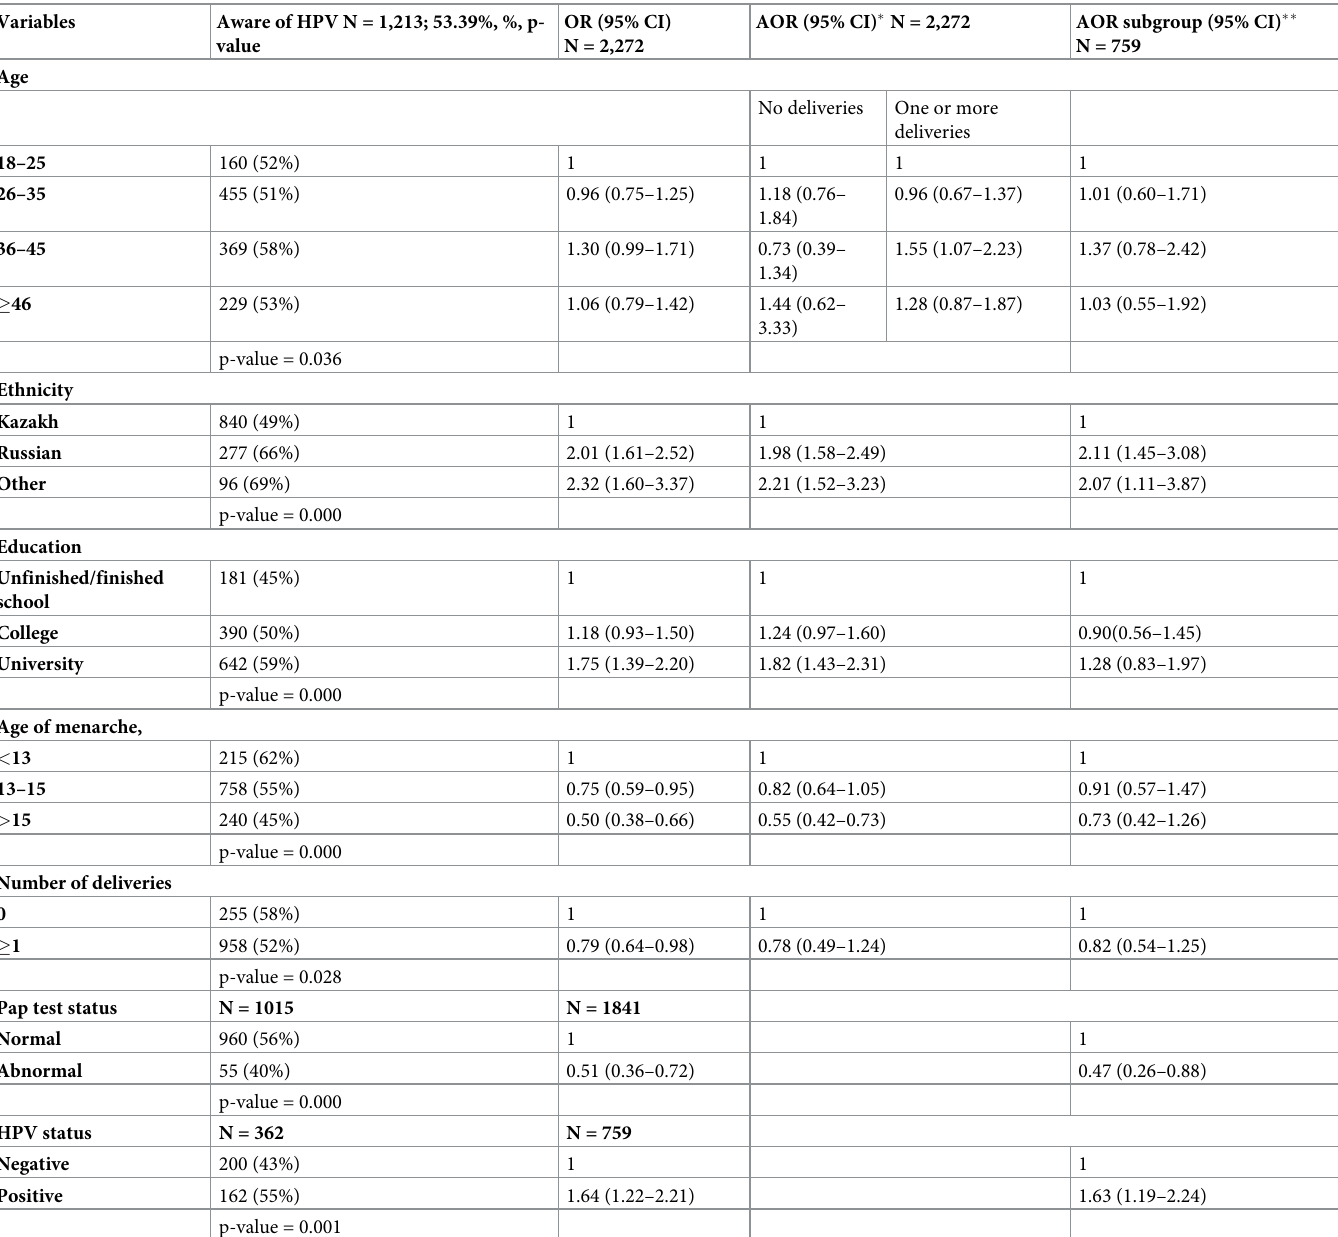
Table 2. Awareness of HPV among women visiting gynecological clinics, (N = 2,272).